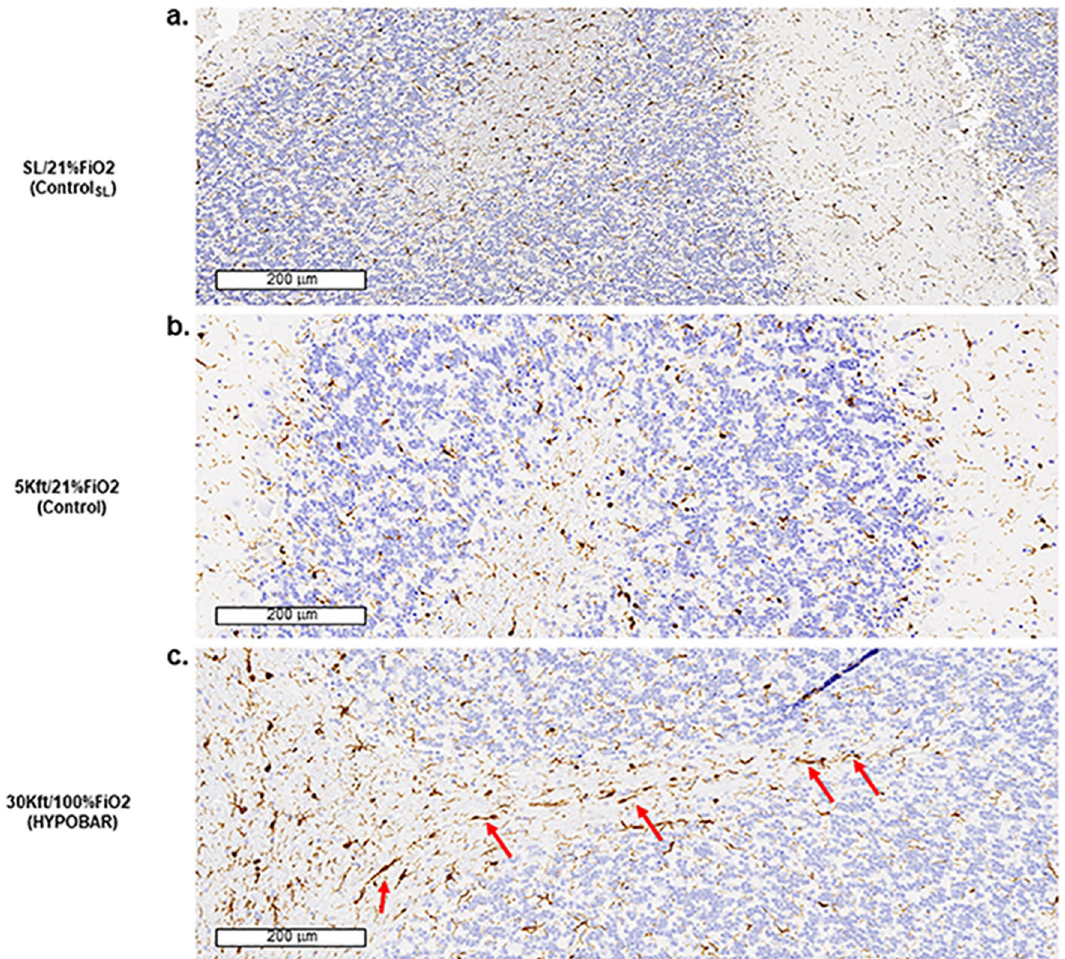
Figure 4. Immunohistochemistry (IHC) outcomes of IBA1 antibody. Panels ( a – c ) are at a scale of 200 microns (µm). Note in panel c the presence of rod-shape microglia cells in the cerebellar “arbor vitae” in the 30Kft/100%FiO 2 (HYPOBAR) group in comparison to the other two groups (SL/21%FiO 2 and 5Kft/21%FiO 2 ). SL sea level, FiO 2 fraction inspired oxygen, HYPOBAR nonhypoxic-hypobaric condition, ft feet, ControlSL SL/21%FiO 2 , Control 5Kft/21%FiO 2